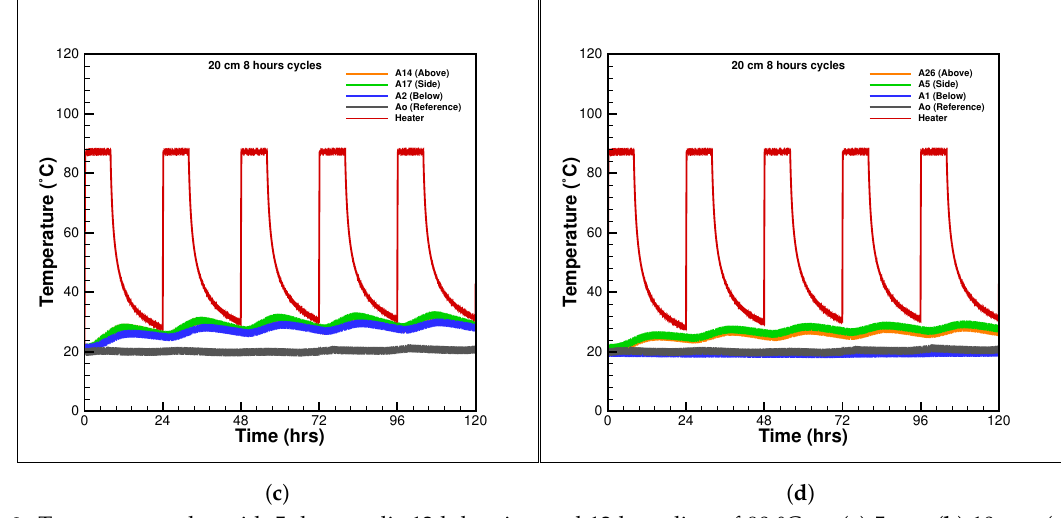
Figure 9. Temperature plot with 5 days cyclic 12 h heating and 12 h cooling of 90 °C at ( a ) 5 cm; ( b ) 10 cm; ( c ) 15 cm; ( d ) 20 cm from the heater surface.